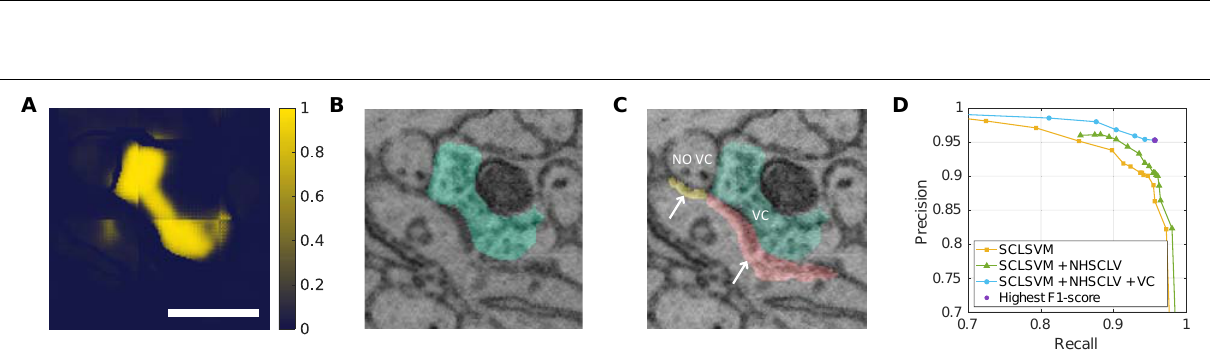
FIGURE 5 | A synapse has a vesicle cloud in the presynaptic side. (A) The VC-Net produces the map of VC likelihood of all the voxels. The map is masked by the neuronal boundaries to prevent the VC from crossing multiple segments of neuronal fragments. A scale bar: 600 nm, 50 voxels. (B) The 3D VC segment (green) is obtained from the map by a watershed algorithm. (C) Two synapse candidate contacts are shown in yellow and red. For each synapse candidate contact, a VC segment is searched for. The yellow contact, which does not have a VC in any of the contacting neurons, is classified as non-synaptic. The red contact, which has a VC in one of the contacting neurons within 5-voxel distance, is classified as synaptic. (D) The PR curve when the VC requirement is added to the SCLSVM and NHSCLV, for varying VC size thresholds. The other two PR curves are repeated from Figure 4D for references. The final step gives the highest F1-score of 0.955, and the VC size threshold is decided to be 1,000